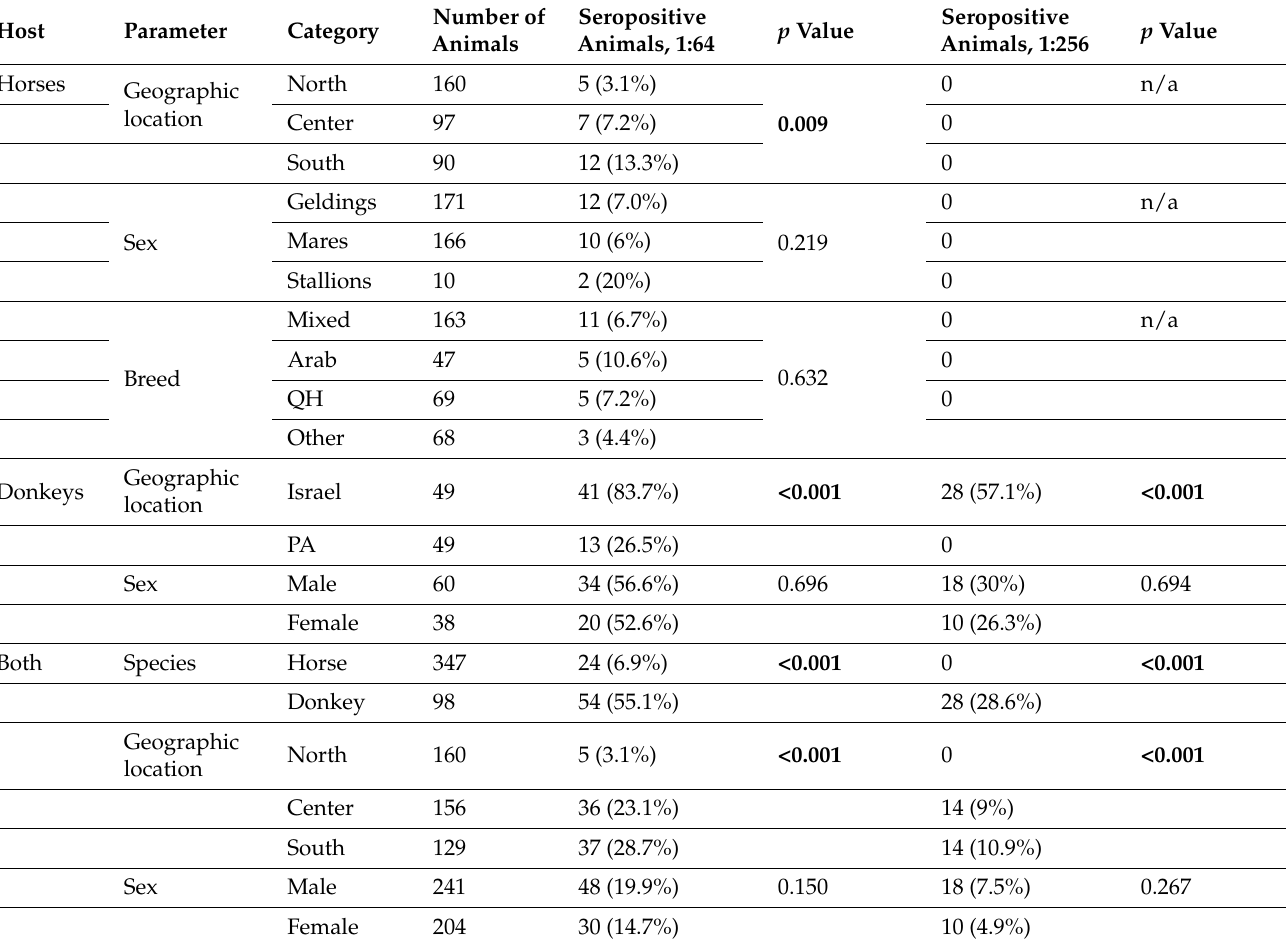
Table 1. The association of various risk factors and the Besnoitia seropositivity in horses and donkeys in Israel, using IFAT cutoff titers of 1:64 and 1:256. Statistically significant results appear in